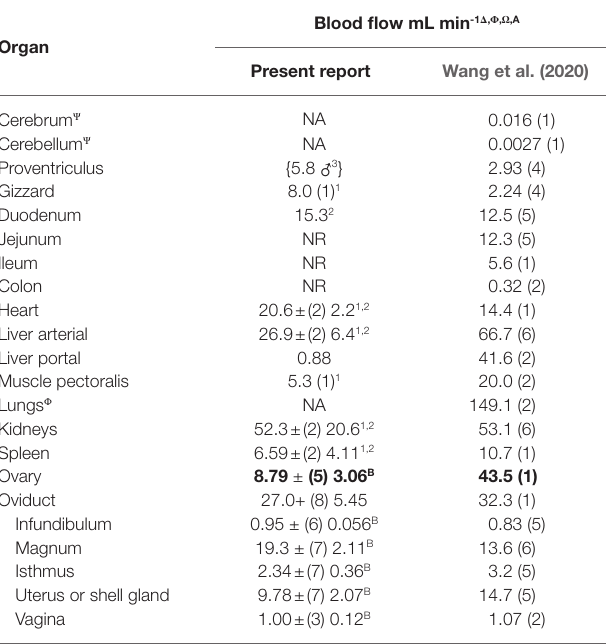
TABLE 8 | Comparison of blood flow in laying hens and those reported by Wang et al. (2020). Organ